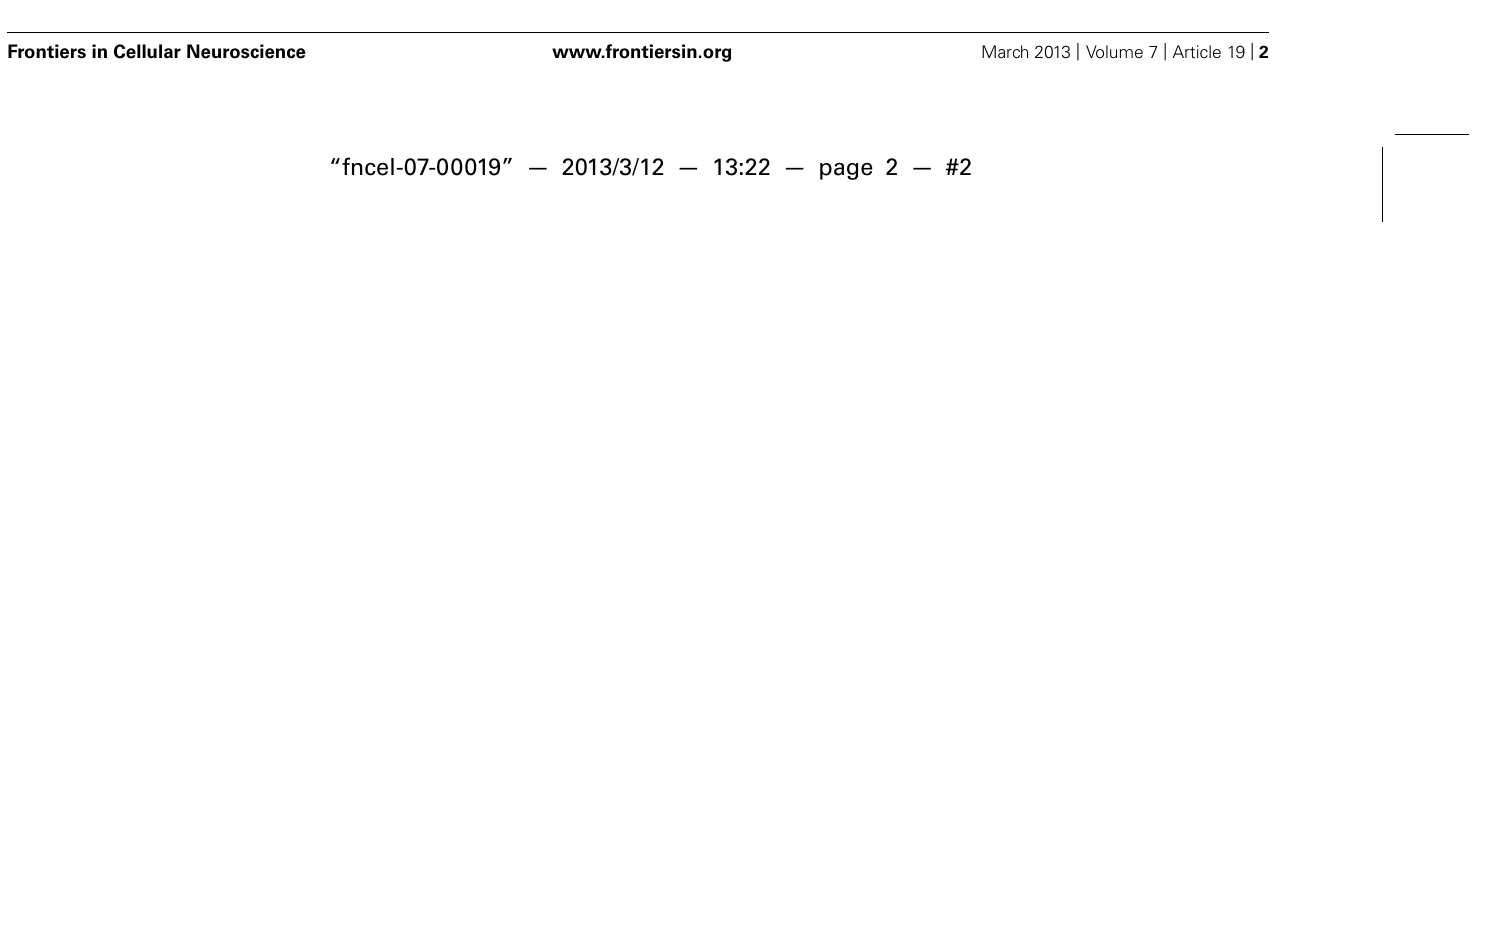
leading to seizures ( Figure 1 ). Less clear, however, is